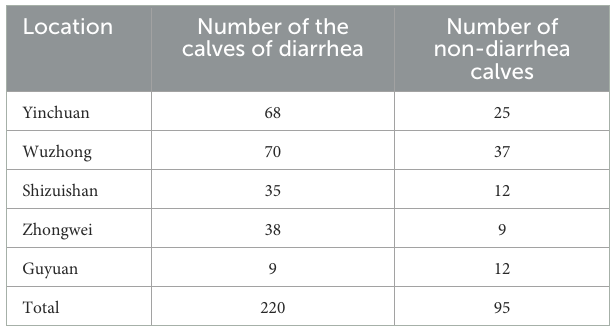
TABLE 1 The total number of samples with diarrhea and non-diarrhea in five cities. Location Number of the calves of diarrhea